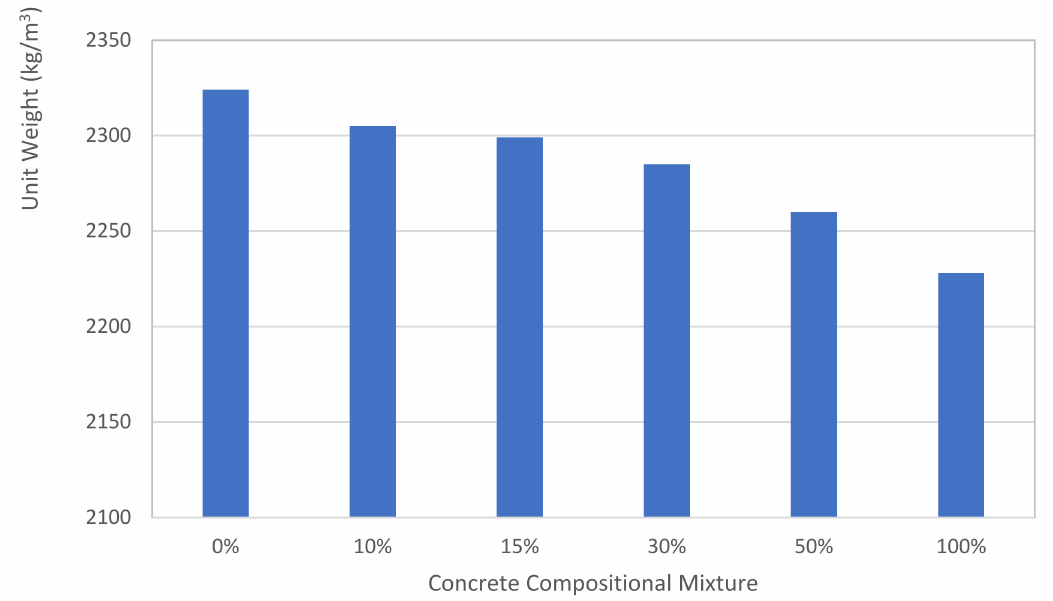
Figure 9. Effect of the proportion of glass sands on the fresh density of